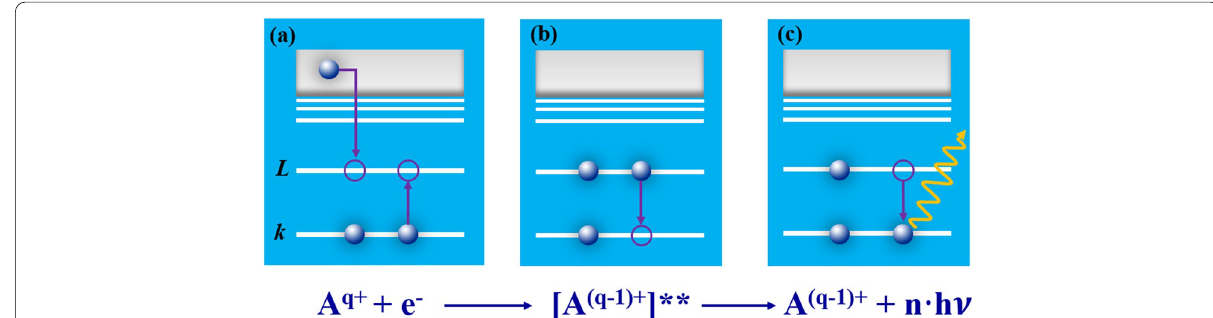
Fig. 10 Schematic diagram of the KLL-DR process of a He-like ion. KLL-DR process means that a free electron is captured into the L orbit of the ion, and simultaneously, a bound electron is excited from the K orbit to L orbit